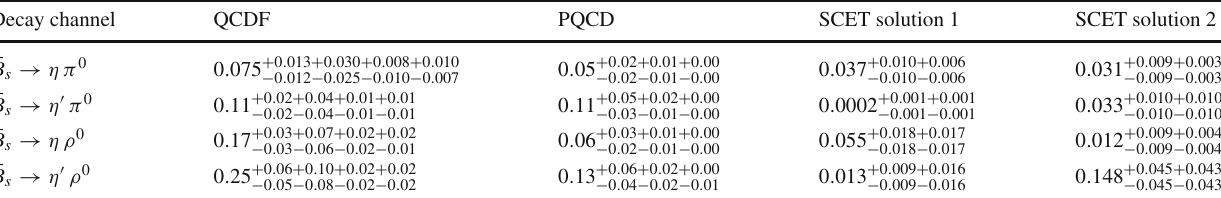
Table 2 Branching ratios of ¯ B 0 s → η ( (cid:3) ) π 0 and ¯ B s → η ( (cid:3) ) ρ 0 decays in 10 − 6 units. The last two columns give the predictions corresponding to the two solutions of the SCET parameters obtained from the χ 2 fit. On the SCET predictions the errors are due to SU(3) breaking effects